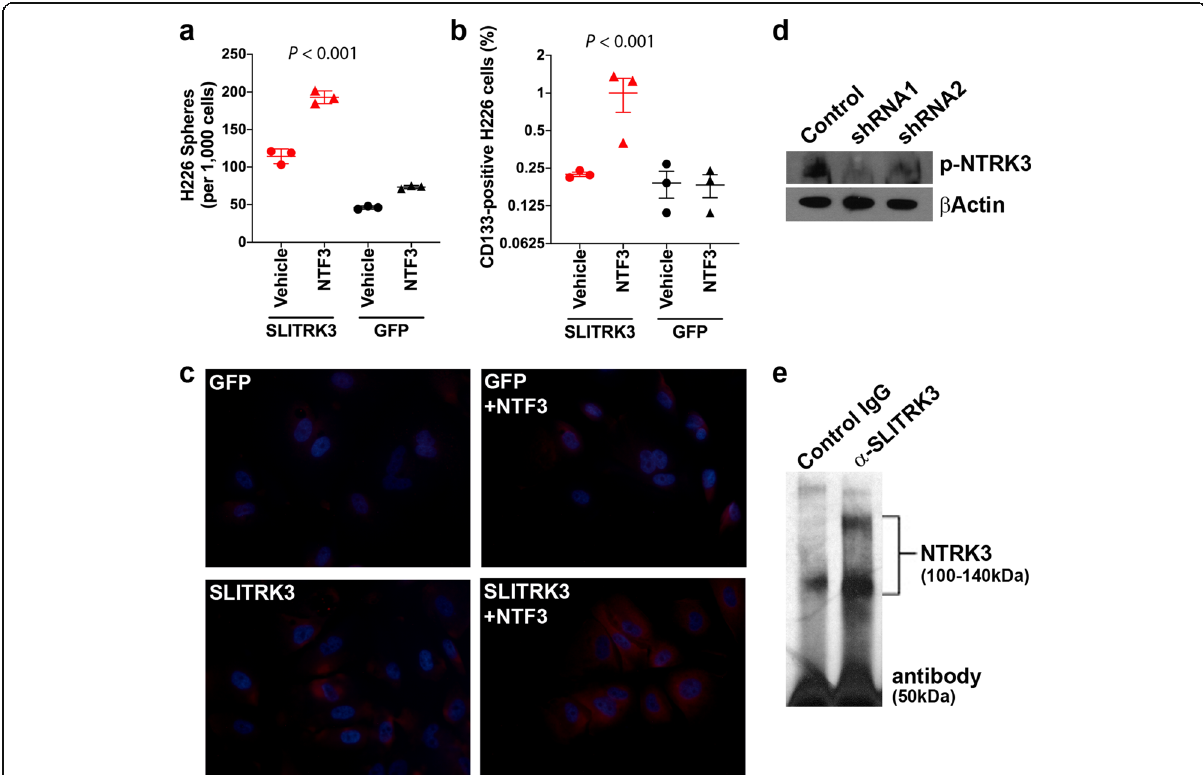
Fig. 4 SLITRK3 overexpression potentiates the effect of NTF3 treatment to increase CSCs and NTRK3 phosphorylation. (a) CSC sphere formation assays assessing the effect of vehicle or 5 ng/mL NTF3 treatment (7 days) on GFP-expressing (black) or SLITRK3 overexpressing (red) H226 cells. Lines, SEM. (b) Impact of SLITRK3 overexpression and NTF3 treatment on the fraction of CSCs relative to total cell count based on FACS analysis of CD133+ status . Lines, SEM. (c) In situ immunofluorescent detection (red) of phosphorylated NTRK3 (p-NTRK3) in H226 cells expressing GFP or overexpressing SLITRK3, with or without NTF3 treatment. Nuclei (blue) were stained with DAPI. ( d ) Western blot analysis of p-NTRK3 levels in HARAB cells following stable knockdown of SLITRK3 by shRNA vectors (shRNA1 and shRNA2) relative to a nonsilencing control vector. ( e ) Result of immunoprecipitation performed using whole cell lysates from HARAB cells. A SLITRK3 antibody was used for immunoprecipitation and a NTRK3 antibody for Western blot detection. The bracket indicates the 2 bands that correspond to NTRK3. Rabbit IgG was used as the negative control. The band at 50 kDa corresponds to the antibody heavy chain subunit. Results are representative of 3